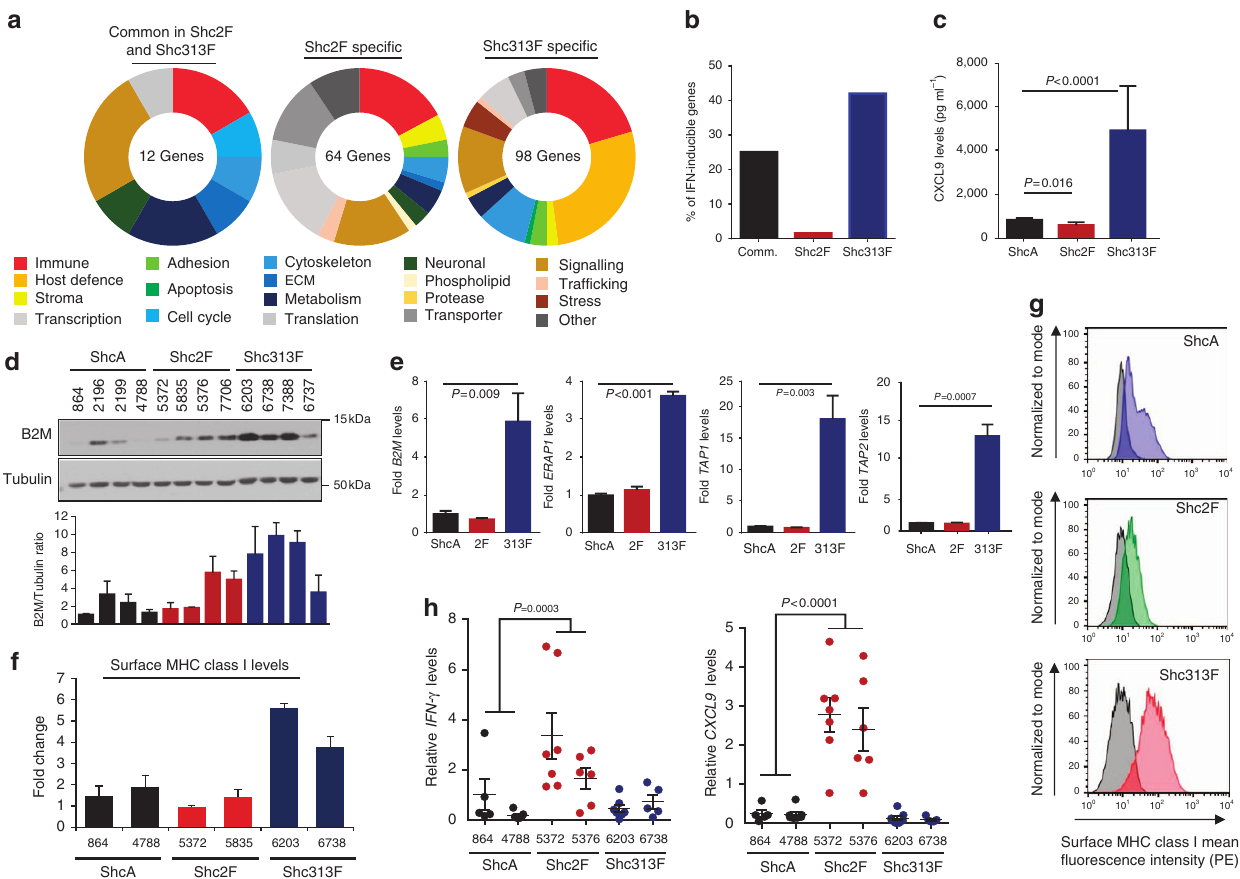
Figure 2 | An intact ShcA pathway restrains IFN-driven immune responses in breast cancer cells. ( a ) RNAseq was performed on cell lines derived from four independent MT/ShcA þ / þ , MT/Shc 2F/2F and MT/Shc 313F/313F mammary tumours. Genes that were significantly differentially regulated in all four cell lines were identified and stratified into three groups: 2F-specific (64 genes), 313F-specific (98 genes) or commonly differentially expressed in 2F and 313F cells relative to WT ShcA (12 genes). ( b ) Percentage of IFN-regulated genes identified by RNAseq ( a ) within each signature. ( c ) Average CXCL9 protein levels (ngml (cid:2) 1 ) secreted from two independent MT/ShcA þ / þ , MT/Shc 2F/2F and MT/Shc 313F/313F breast cancer cells ( n ¼ 5–6 supernatants per cell line) following a 24h IFN g (1ngml (cid:2) 1 ) stimulation as determined by ELISA ( ± s.d.). ( d ) Top: immunoblot analysis of the indicated breast cancer cell lines